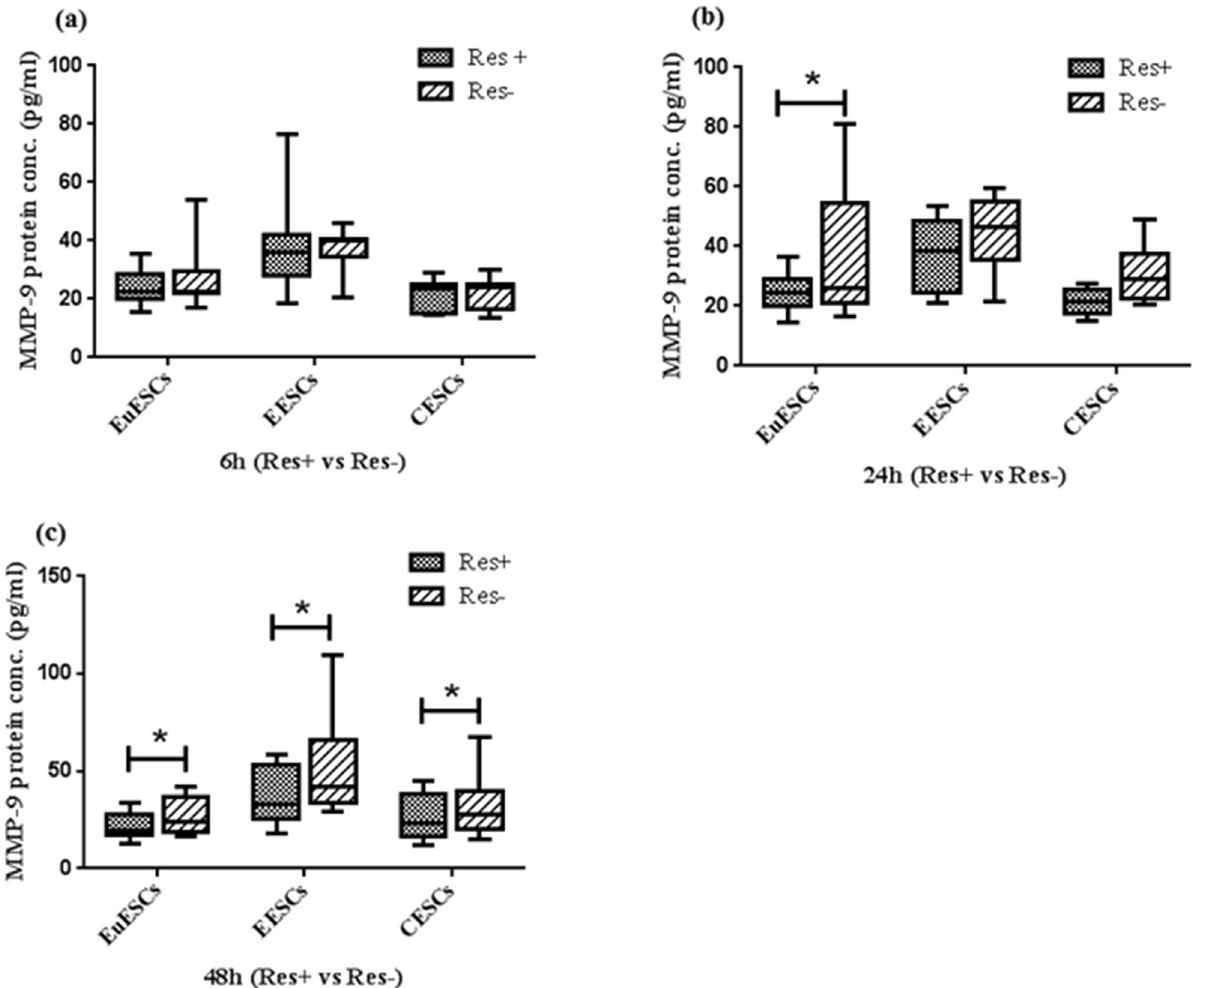
Figure 4. Resveratrol Decreased the Expression of MMP-9 Protein in all ESCs. ESCs from endometriotic women (8 EESCs and 13 EuESCs) and non-endometriotic controls (11 CESCs) were cultured with or without of 100 µM resveratrol. After 6, 24, and 48 h, the protein expression of MMP-9 was examined using ELISA. ( a ) 6 hr (Res + vs Res-), ( b ) 24 hr (Res + vs Res-), (c) 48 hr (Res + vs Res-). *P-value < 0.05 by non-parametric tests. MMP- 9: Matrix metalloproteinase-9, EuESCs: Eutopic endometrial stromal cells, EESCs: Ectopic endometrial stromal cells, CESCs: Control endometrial stromal